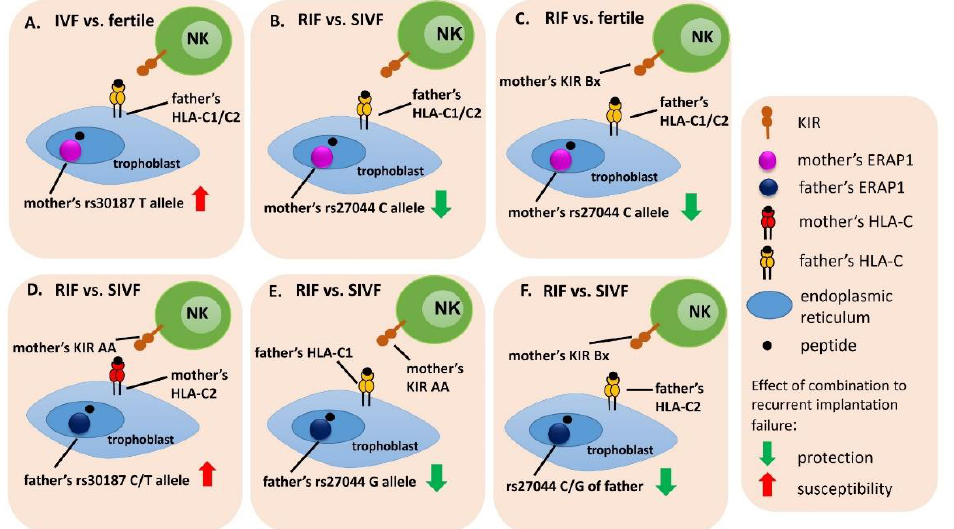
Figure 8. Potential interactions between a woman and her partner in genetic combinations of KIR/HLA-C/ERAP and the effect on susceptibility and protection to infertility and recurrent implan- tation failure ( A – F ). IVF means all patients undergoing in vitro fertilization; RIF means patients with recurrent implantation failures; SIVF means patients with successful pregnancy after